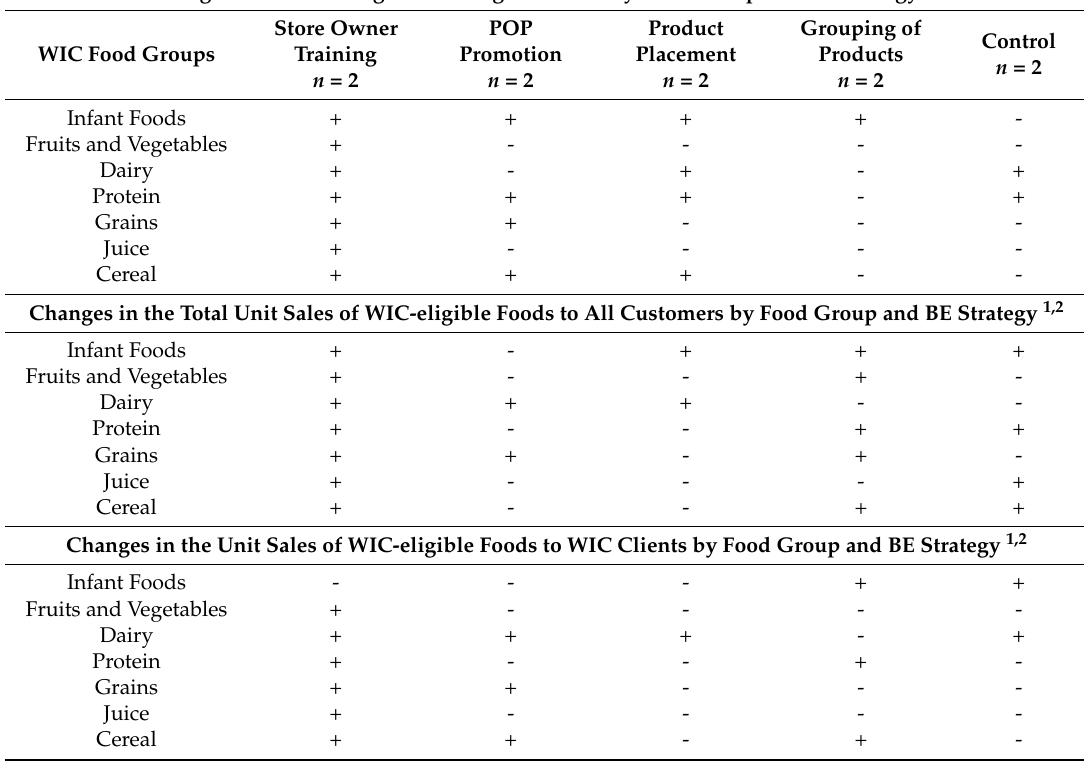
Table 4. Qualitative changes in the stocking of WIC foods, total unit sales of WIC foods to all customers, and unit sales of WIC foods to WIC clients in intervention stores compared to control stores, following implementation of one BE strategy, for different food